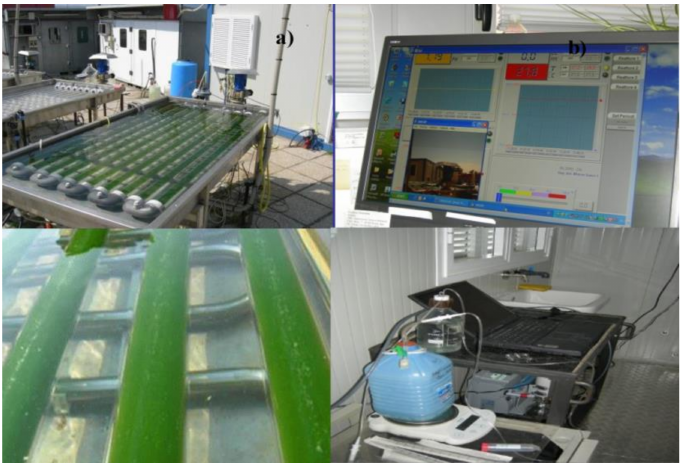
Figure 7. The tubular photobioreactor (working volume 50 L) used for the outdoor H 2 production experiments. The photobioreactor was equipped with probes for measurement and control of pH and temperature. Culture speed can be adjusted to reach the desired